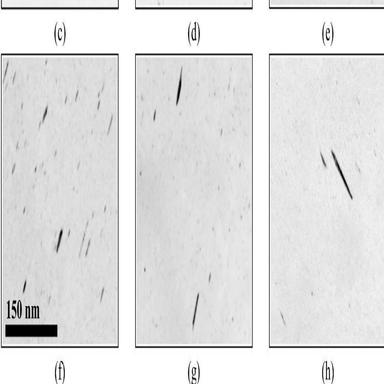
Dark-field micrographs of dislocation loops after 150 dpa, dual ion irradiation: stainless steels (a) 316L and (b) 310; precipitate-strengthened, Ni-base alloys (c) X750, (d) 718, and (e) 725; and solid solution, Ni-base alloys (f) 690, (g) 625, and (h) C22. Micrographs were captured using rel-rod imaging, with intensity values inverted to improve the visibility of small defects.